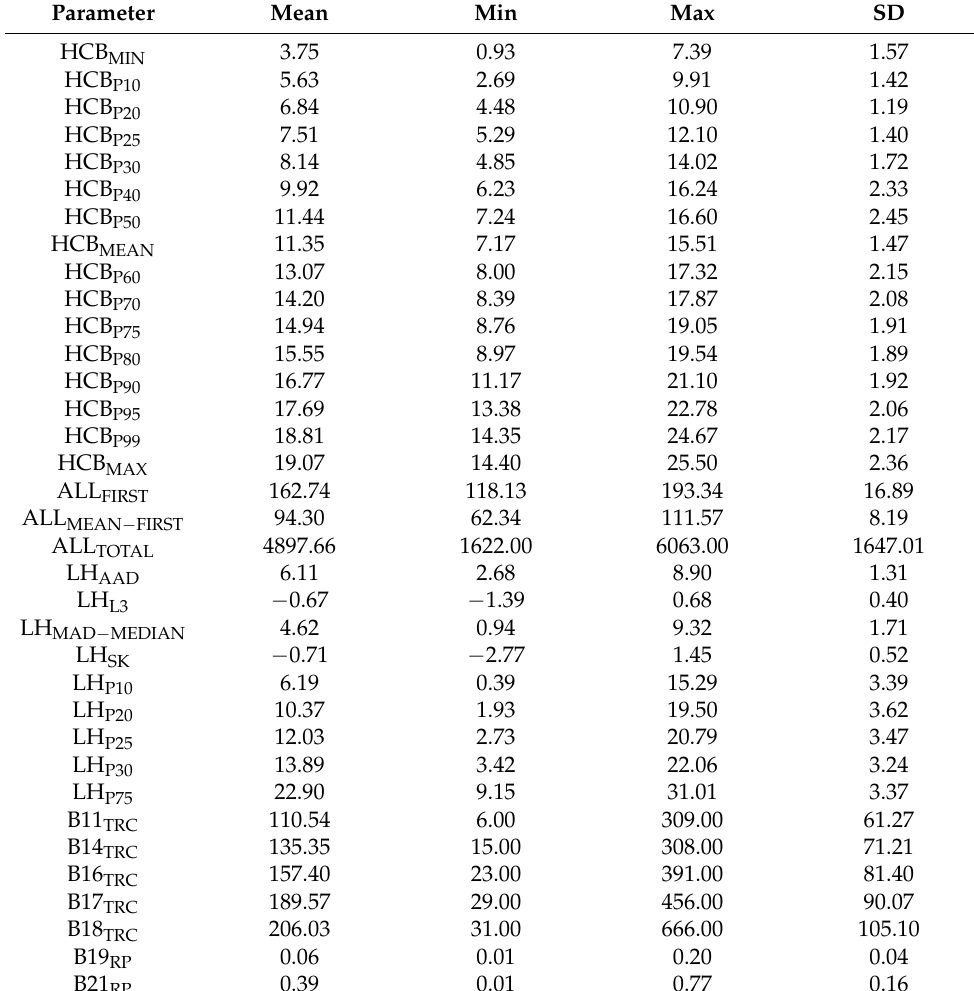
Table A1. Statistical summary of dependent variables (HCB M ) and predictor variables of the HCB models (LiDAR metrics) (see acronyms in Figure 3). Data used to create Figure